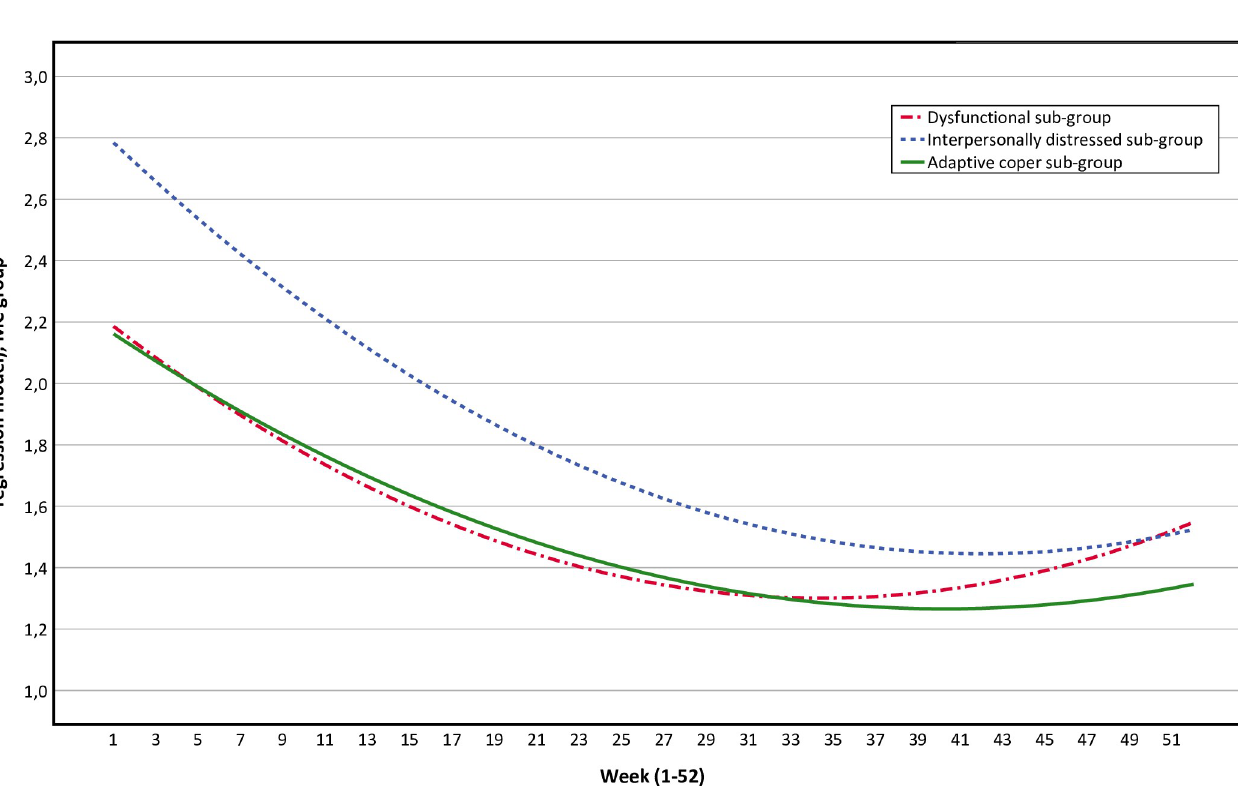
Fig 6. Pain trajectories for the maintenance care group (all sub-groups).